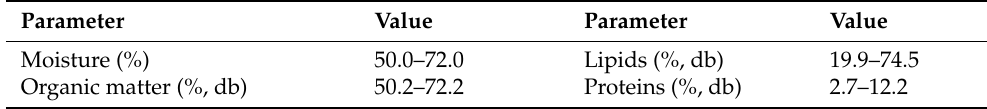
Table 5. General composition of grape